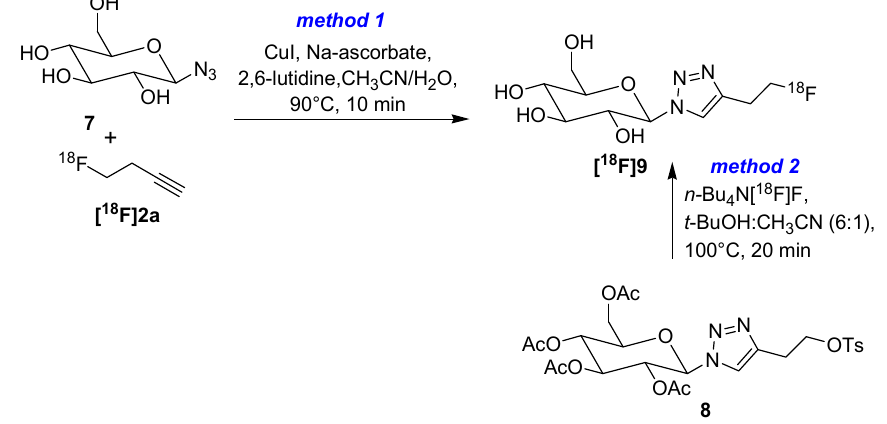
Scheme 6. Comparison of conventional nucleophilic labeling with click